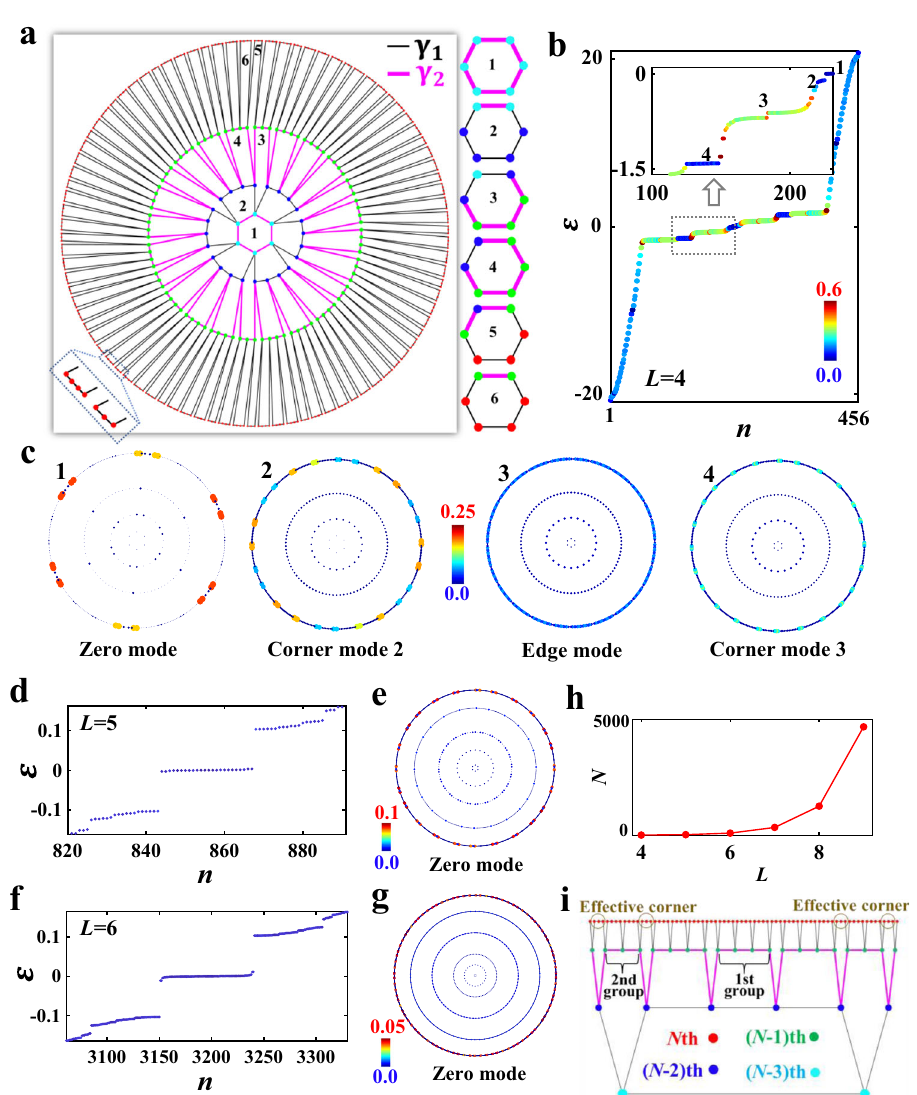
Fig. 3 Fractal-like higher-order zero modes in the deformed hyperbolic lattice. a The deformed hyperbolic lattice model for realizing fractal-like higher- order zero modes with L = 4 layers. Right insets plot coupling patterns in hexagons composed of lattice sites from different layers. b The calculated eigen- spectrum of the system with L = 4. The colormap corresponds to the PR of each eigenmode. The inset presents the enlarged spectrum with eigenenergies ranging from − 1.5 to 0. c Pro fi les of the normalized density of states of eigenmodes in four different energy regions. d , f The eigen-spectra of the hyperbolic lattice with L = 5 and L = 6, respectively. e , g Density of states of zero modes with L = 5 and L = 6, respectively. h The relationship between the number of midgap zero modes and the layer number ( L ) of deformed hyperbolic lattices. i Schematic diagram illustrating the effective corners in the outermost ring in the deformed hyperbolic (marked by the number 1 in the inset) show the signi fi cant fi eld- localization, which is manifested by the near-zero PR . The PR s of two other kinds of midgap eigenmodes around ε ¼ (cid:2) 0 : 1192 and ε ¼ (cid:2) 1 : 41 (marked by numbers 2 and 4) also approach to zero, indicating the strong spatial localizations. In contrast, eigenmodes marked by the number 3 exhibit spatially extended features with larger values of PR . To further illustrate the distribution of each eigenstate, spatial pro fi les of density of state for these four types of eigenmodes are calculated, as plotted in Fig. 3c. It is clearly shown that the mode distribution of zero-energy eigenstates (labeled by the number 1 and called as the zero mode) is strongly localized around six 0D effective corners, which are different from the real geometric corners in the form of intersections between 1D